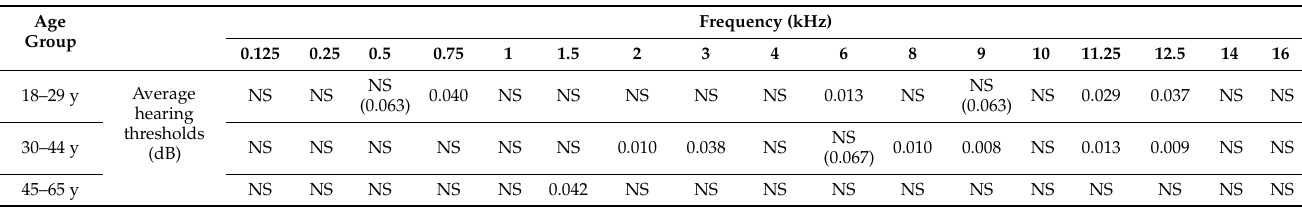
Table 2. Comparison of the average hearing thresholds of respondents exposed and unexposed to workplace noise (in terms of p -values).